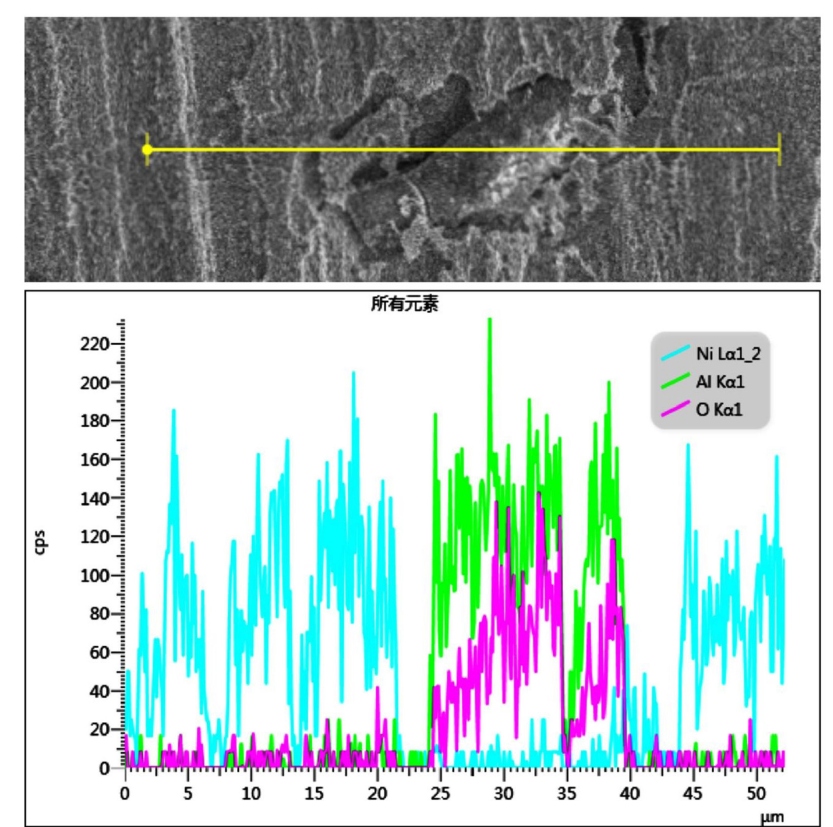
Figure 12. Energy spectrum analysis of inclusions in joint